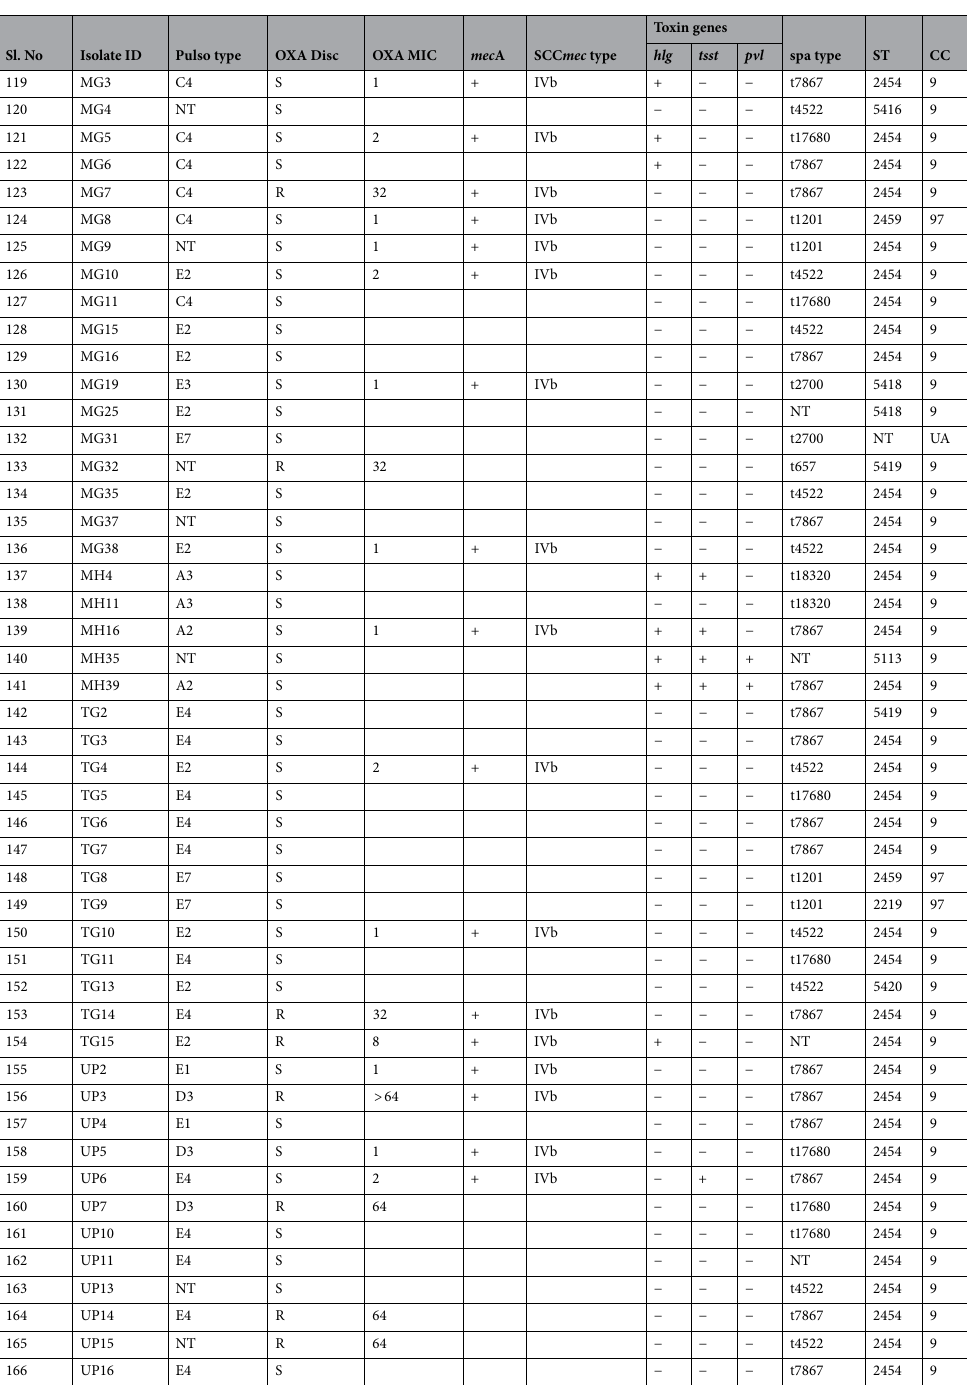
Table 1. State-wise details of isolates and their characteristics. CC = Clonal complex; GJ = Gujarat; KA = Karnataka; MG = Meghalaya; MH = Maharashtra; MIC = minimum inhibitory concentration; OXA = oxacillin; NT = Non-typable; ST = Sequence Type; TG = Telangana; UA = Unassigned; UP = Uttar